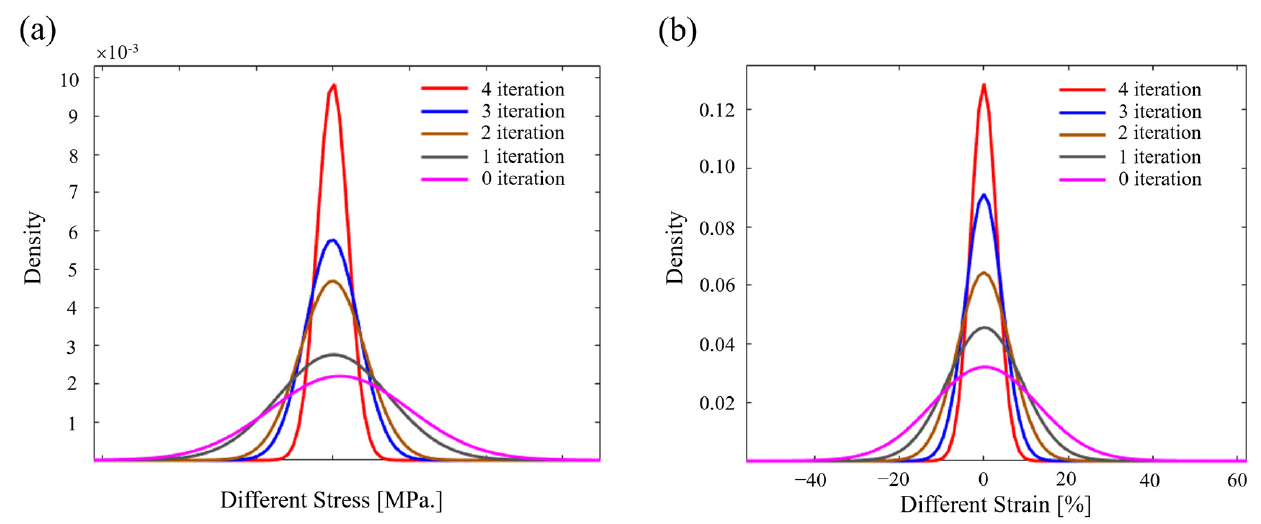
Figure 6. Probability distribution function of different ( a ) stress and ( b ) strain distributions between 3D result and iteratively revised 2D result for the ferrite phase of case 1 with different iterative steps.